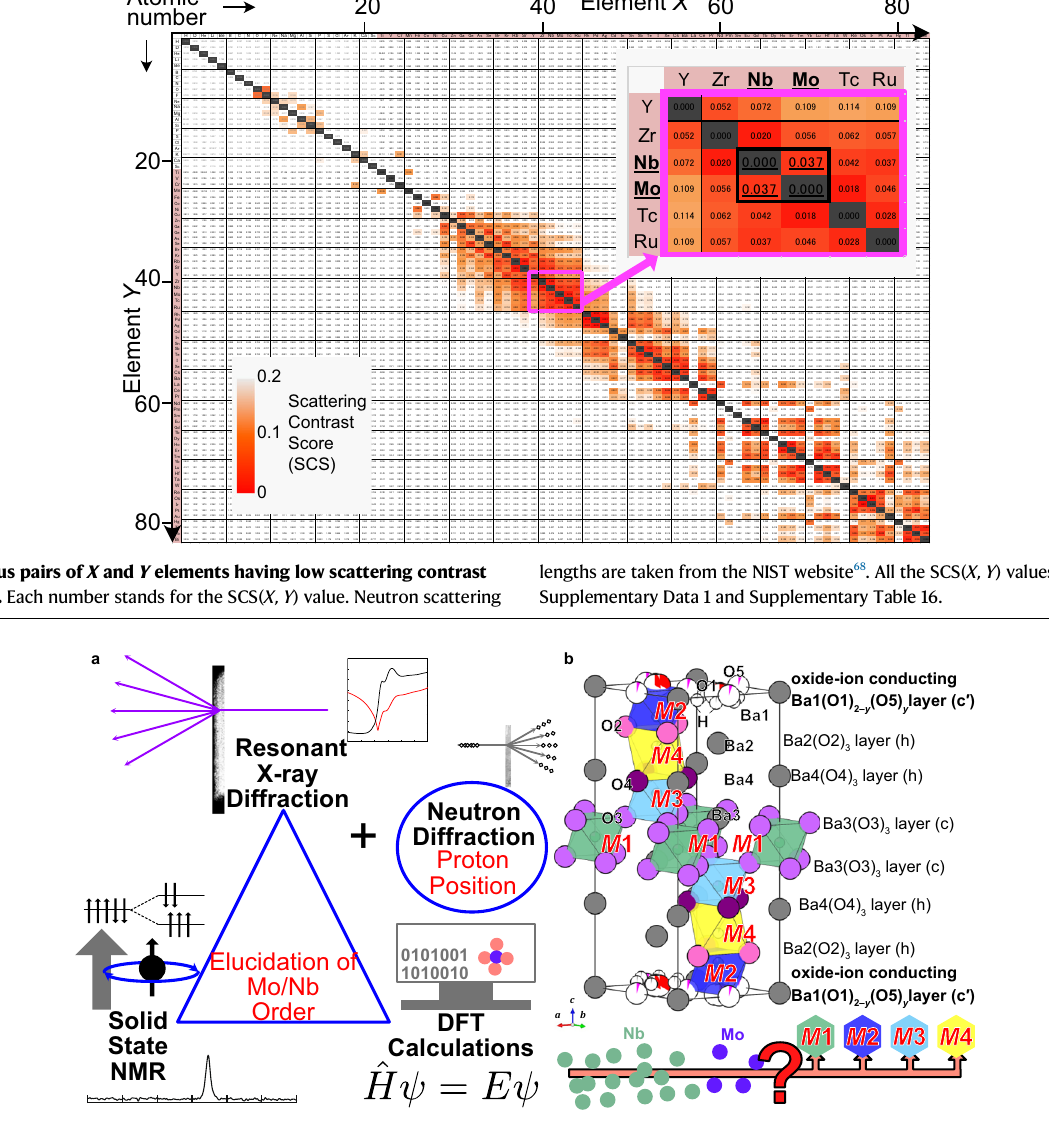
structure showing the M 1, M 2, M 3 and M 4 sites of Mo and Nb atoms in